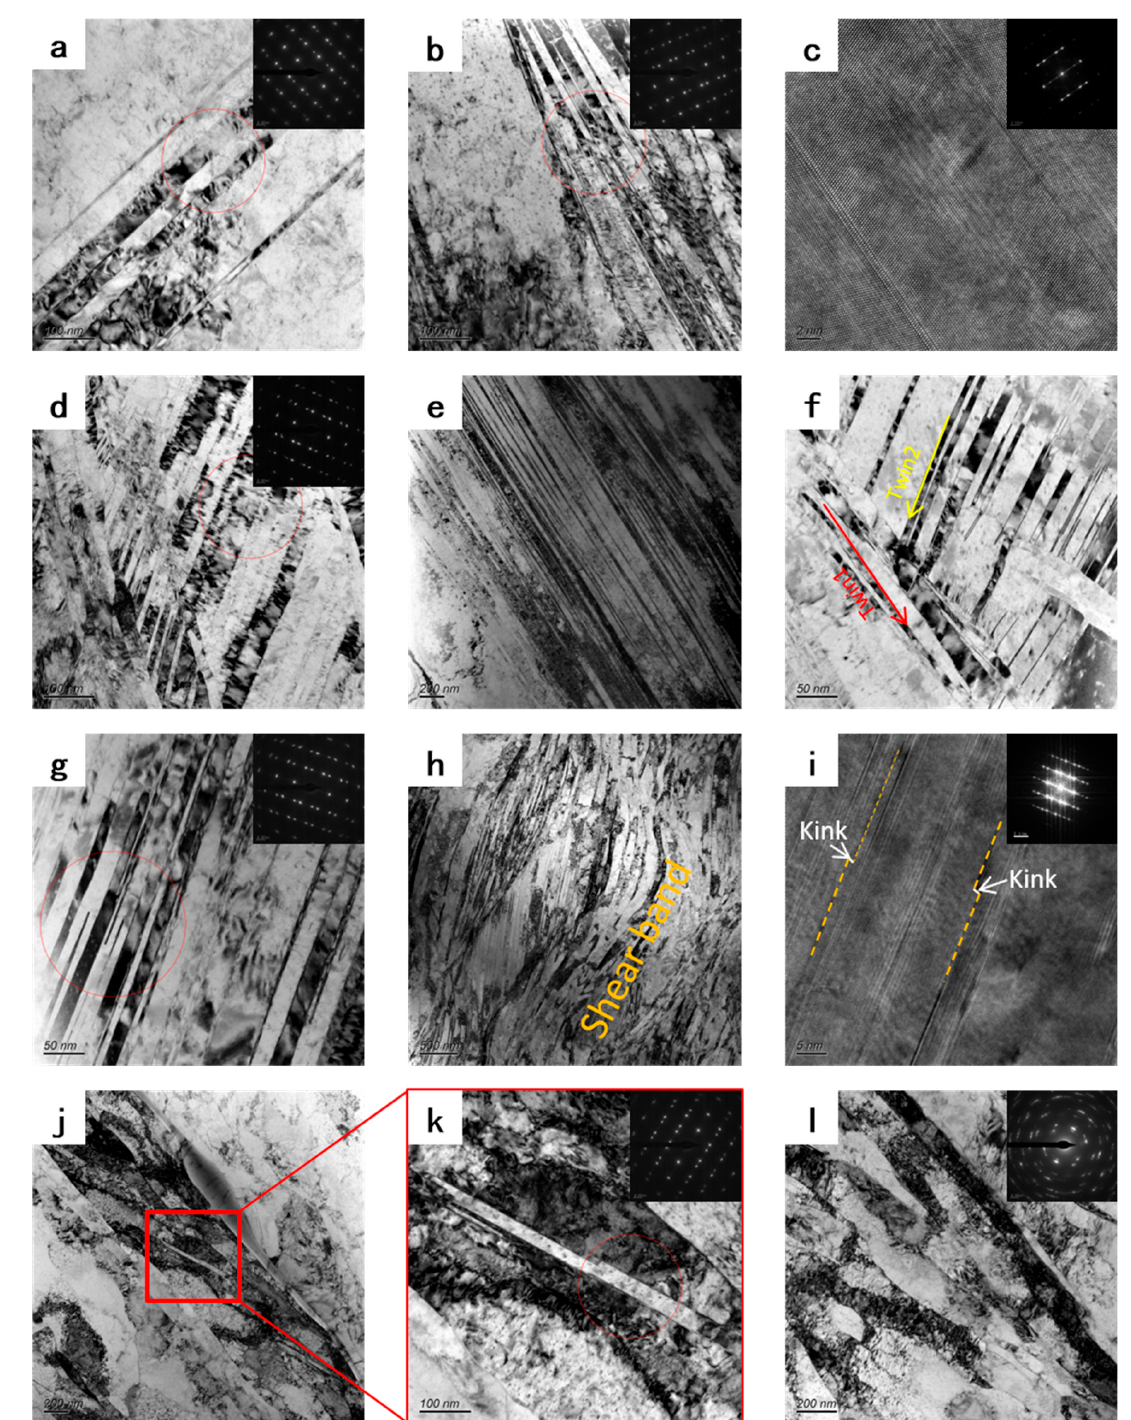
Figure 10. TEM images showing the microstructural evolution of CTR samples with different re- ductions: ( a – c ) CTR30, ( d – f ) CTR 60, ( g – i ) CTR 80, and ( j – l ) CTR